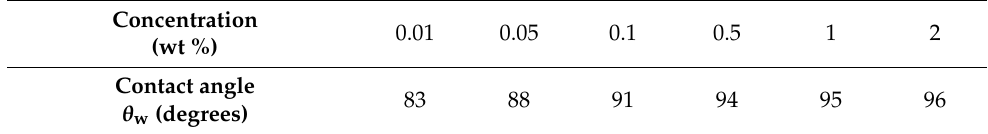
Figure 3. POM photographs of PSLC alignment in CNT-PDB brush-coated hybrid cells at different spin-coating concentrations: ( a ) 2, ( b ) 1, ( c ) 0.5, ( d ) 0.1, ( e ) 0.05, and ( f ) 0.01 wt%. Table 1. Water contact angle ( θ w ) on the CNT-PDB brush